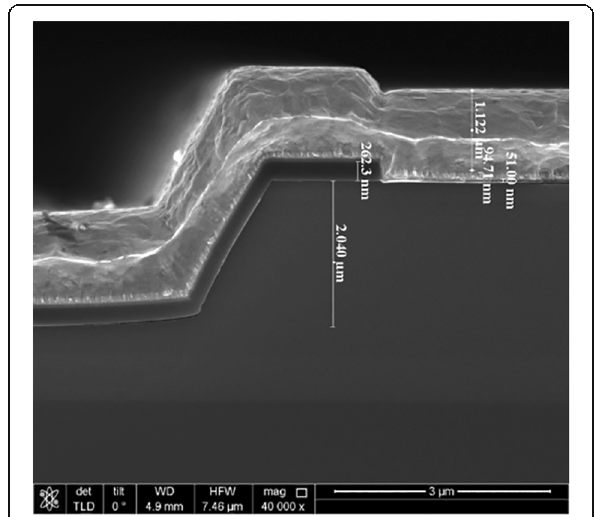
Fig. 5 SEM image of the laser's cross section. The F-P broad area laser with a standard laser fabrication process. GaAs/AlGaAs etch depth is about 2- μ m. The PECVD formed SiO 2 is 260 nm